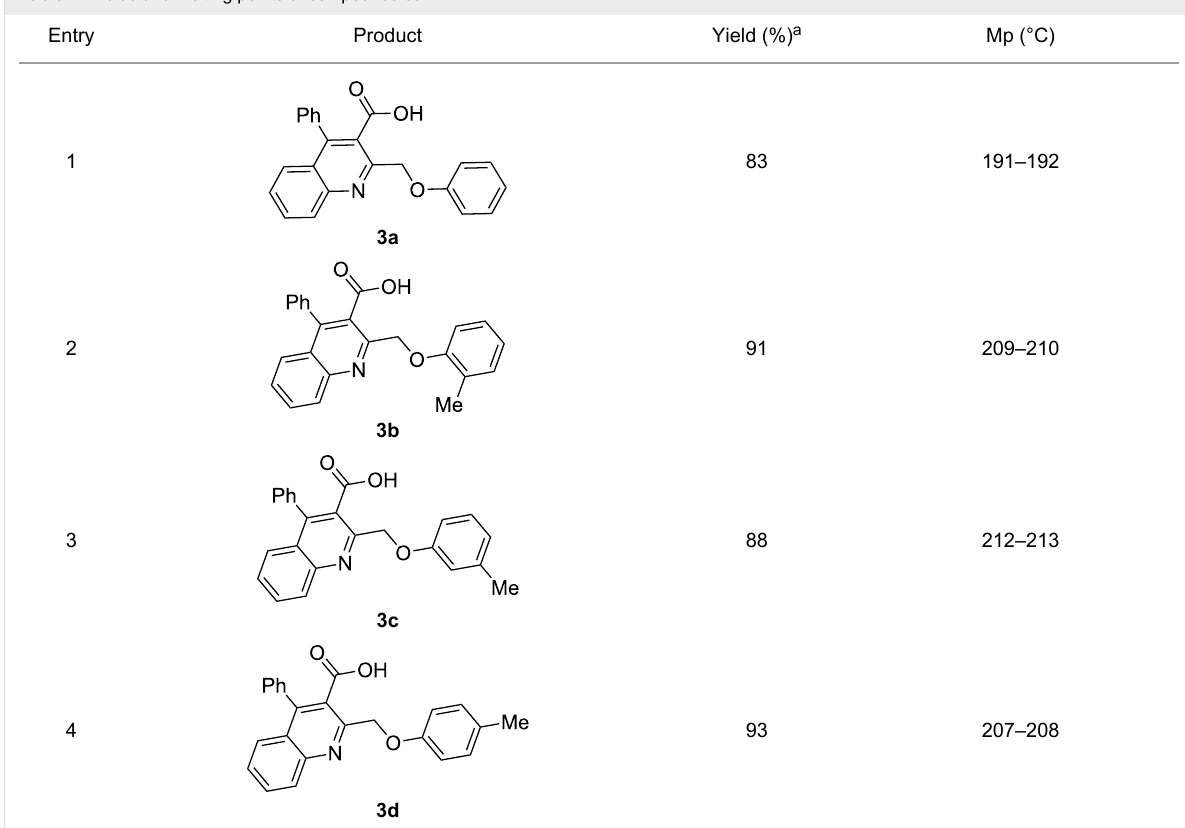
Table 1: Yields and melting points of compounds 3a – l